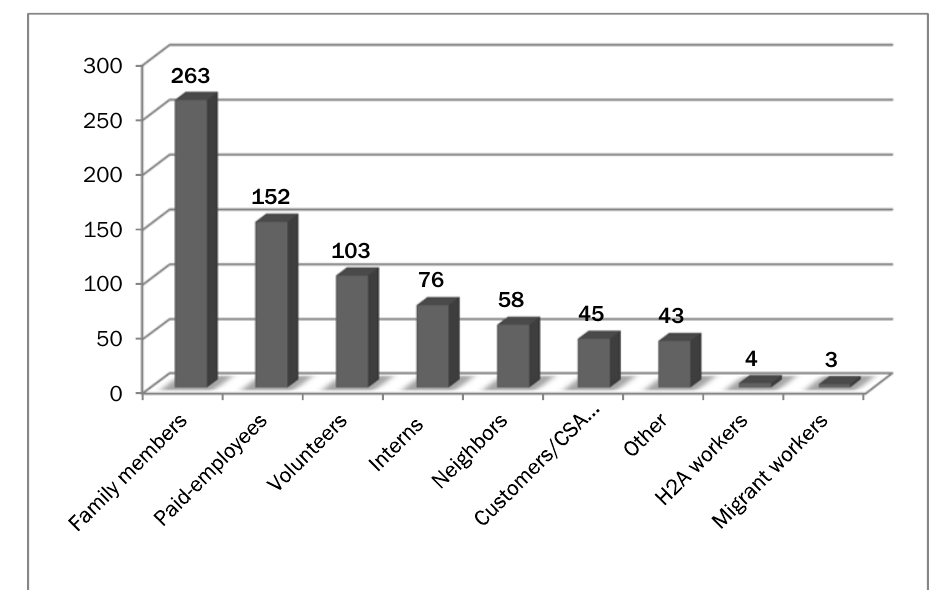
Figure 1. Number of Farms by Type of Labor ( N